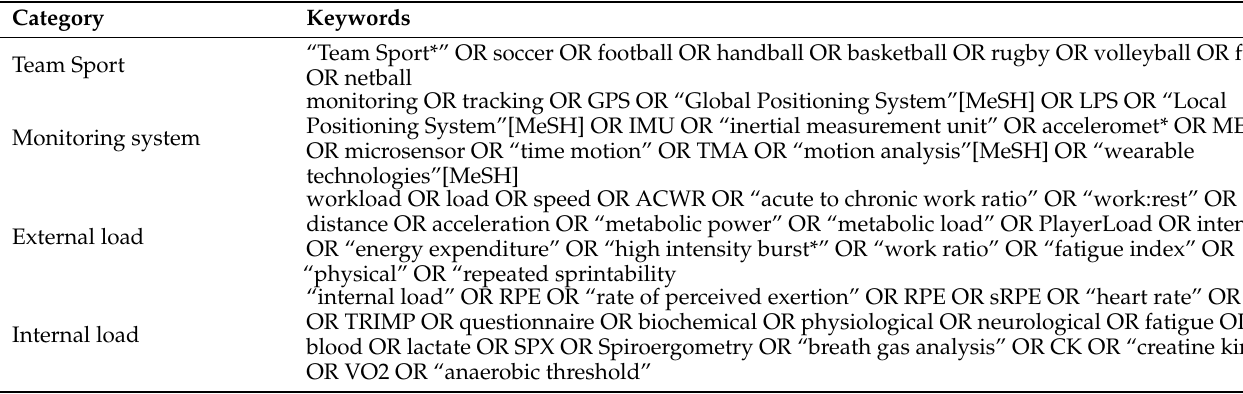
Table 1. Search Term: Categories are connected with the Boolean operator “AND”; key words within a category are connected with